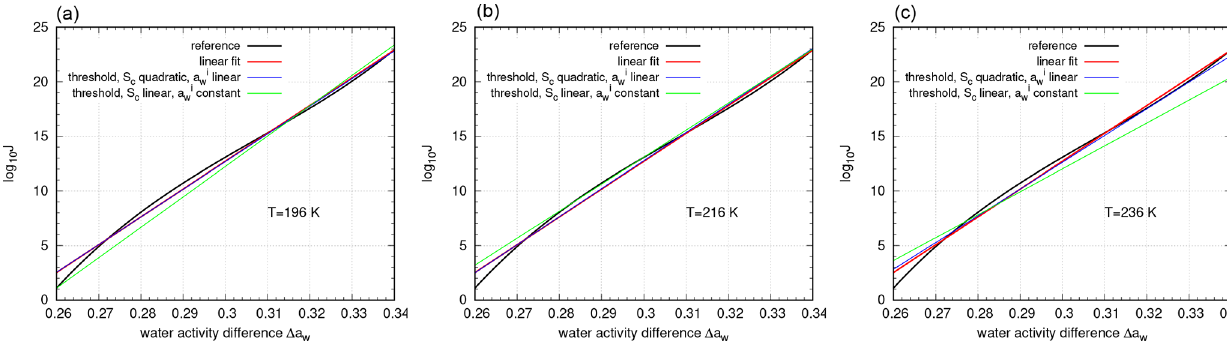
Figure 3. Different approximations of nucleation rate for different temperatures ( a : T = 196K, b : T = 216K, c : T = 236K). Black – reference nucleation rate; red – linear fit to reference nucleation rate; blue – threshold description due to Eq. (43), using a linear approximation for a i w and a quadratic threshold function S c ; green – threshold description due to Eq. (43), using a constant for a i w and a linear threshold function S c .